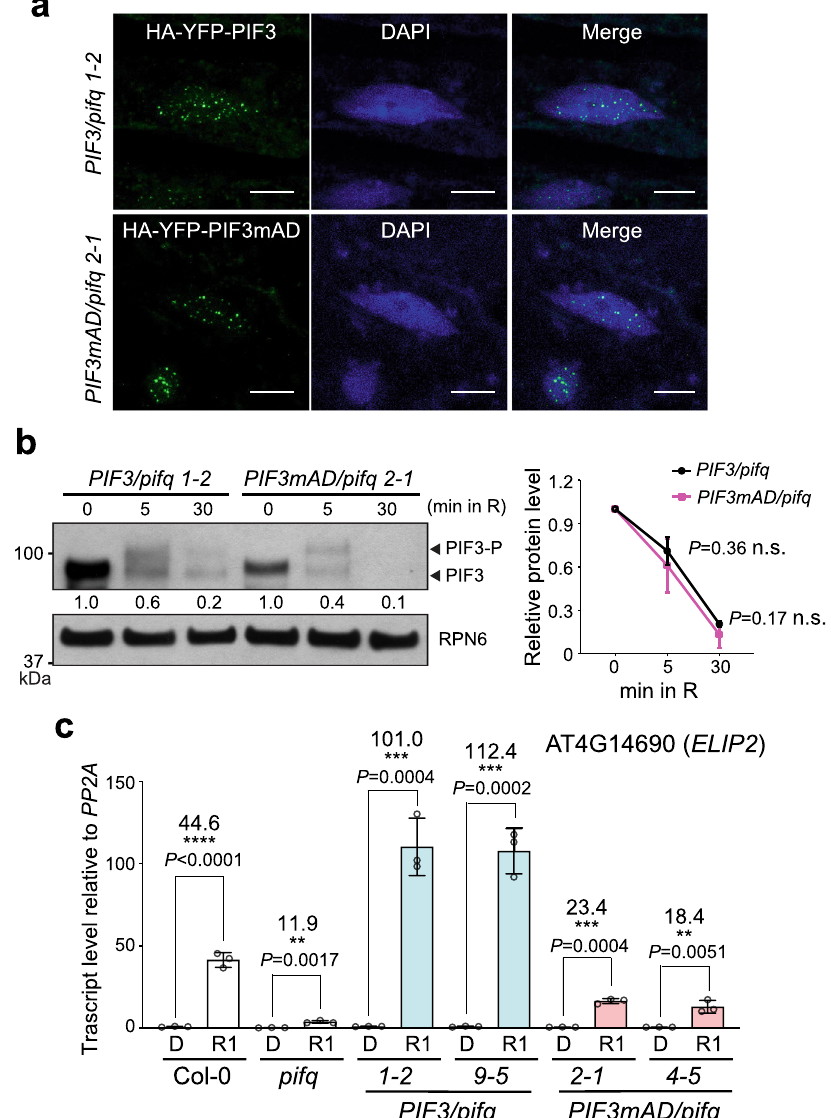
Fig. 5 Characterization of PIF3mAD in early light signaling. a Confocal images showing the nuclear body localization of HA-YFP-PIF3 and HA-YFP- PIF3mAD in the hypocotyl epidermal cells of dark-grown PIF3/pifq (line 1-2 ) and PIF3mAD/pifq (line 2-1 ) seedlings after 1 min of exposure to 10 μ molm − 2 s − 1 R light. Nuclei were stained with DAPI. The scale bars represent 5 μ m. The localization patterns of HA-YFP-PIF3 and HA-YFP-PIF3mAD were observed in at least fi ve individual seedlings of each line. b Immunoblots showing the phosphorylation and degradation of HA-YFP-PIF3 and HA-YFP-PIF3mAD in 4-d-old PIF3/pifq and PIF3mAD/pifq seedlings during the dark-to-light transition at the indicated time points in 10 μ mol m − 2 s − 1 R light. HA-YFP-PIF3 and HA-YFP- PIF3mAD were detected using anti-HA antibodies. RPN6 was used as a loading control. The immunoblot experiments were independently repeated four times, and the immunoblots of one representative experiment are shown. The numbers beneath the PIF3 immunoblot indicate the relative levels of HA-YFP- tagged PIF3 or PIF3mAD relative to the abundance of each line in the darkness. The right panel shows the kinetic changes of HA-YFP-PIF3 and HA-YFP- PIF3mAD during the dark-to-light transition using data from all four experiments. The protein levels of PIF3 and PIF3mAD were quanti fi ed relative to those at time 0. Although PIF3mAD/pifq accumulated slightly less HA-YFP-PIF3mAD than HA-YFP-PIF3 in PIF3/pifq in darkness, the degradation kinetics of HA-YFP- PIF3mAD was the same as that of HA-YFP-PIF3. Error bars represent the s.d. of four biological replicates. The centers of the error bars represent the mean values. The statistical signi fi cance was analyzed using two-tailed Student ’ s t -test. n.s. indicates the values between the PIF3/pifq and PIF3mAD/pifq samples are not signi fi cantly different. c qRT-PCR results showing the steady-state transcript levels of ELIP2 in seedlings of 4-d-old dark-grown Col-0, pifq , and the transgenic PIF3/pifq and PIF3mAD/pifq lines before (D) and 1h after (R1) exposure to 10 μ mol m − 2 s − 1 R light. The transcript levels were calculated relative to those of PP2A . The numbers represent fold changes of the transcript level of ELIP2 in R1h compared to that in D. Error bars represent the s.d. of three biological replicates. The centers of the error bars represent the mean values. The statistical signi fi cance was analyzed using two-tailed Student ’ s t -test (** P ≤ 0.01, *** P ≤ 0.001, **** P ≤ 0.0001). The source data underlying the immunoblots in ( b ) and qRT-PCR data in ( c ) are provided in the Source data fi le.